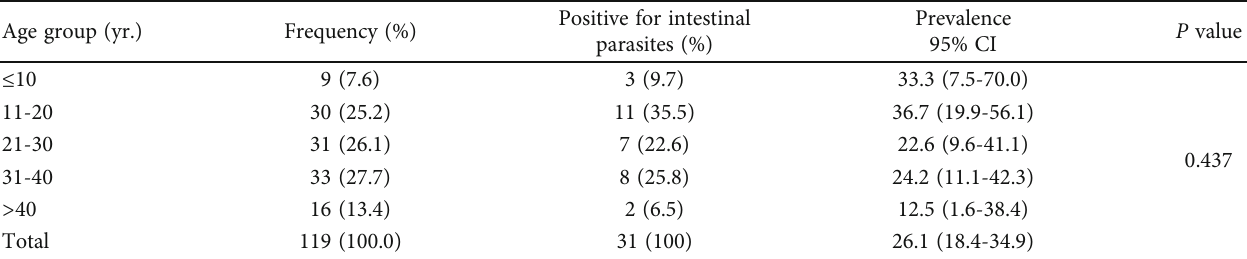
Table 3: Frequency of intestinal parasitic infections based on age, among intellectually disabled individuals in Bandar Abbas County, Southern Iran. Age group